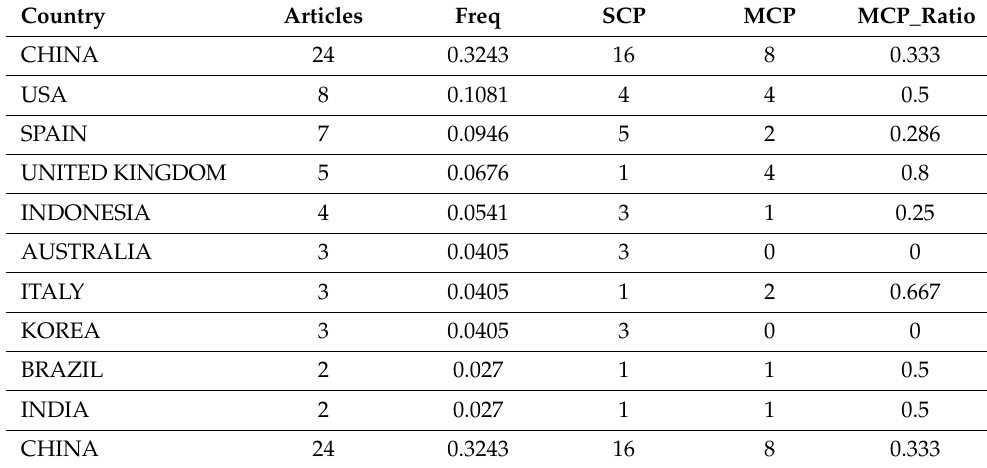
Table 4. Corresponding author’s country.